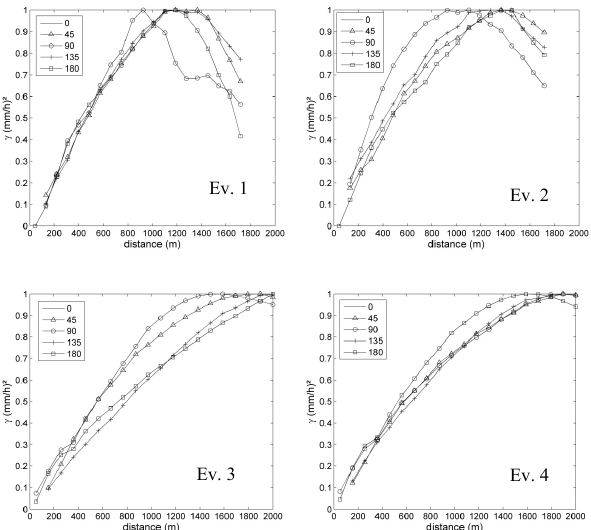
Figure 9. Instantaneous experimental multi-directional spatial semi-variogram of non-zero rainfall for each of the four storms.